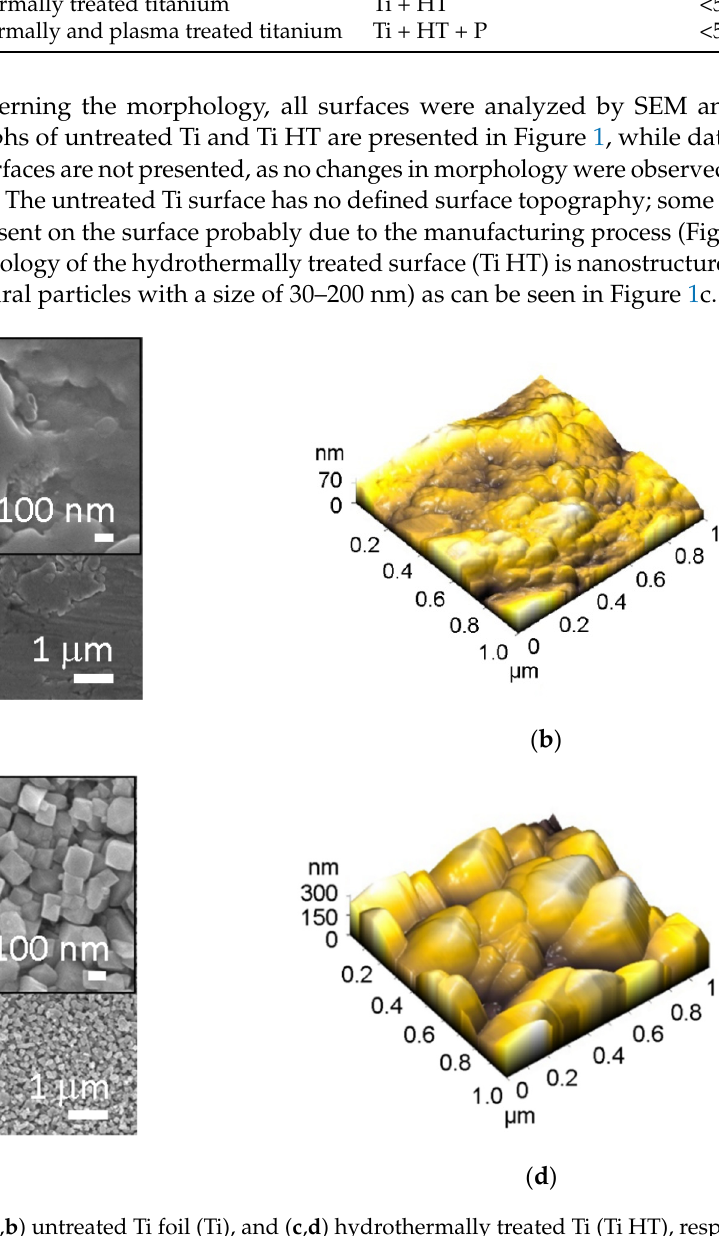
plasma treatment were detected on these surfaces. The 3D image of surface topography (Figure 1b) reveals that plain Ti foil has no defined topography; the estimated surface roughness (Ra) is about 11.7 nm for the 1 × 1 µm 2 scan area. On the other hand, much higher roughness (49 nm) was measured for the hydrothermally treated surface (Ti HT) for the same scan area. In the case of hydrothermal treatment, the evaluated height of the octahedral particles is between 180 and 300 nm. Thus, the main difference between Ti and Ti HT surface is that the TiHT exhibits homogenous structured nanotopography, which may significantly influence biological response. As determined from X-ray photoelectron (XPS) analysis (Table 2), the untreated Ti substrate consists of 48.5 at. % of oxygen, 19.5 at. % of titanium and 32.0 at. % of carbon. Oxygen concentration on the surface of Ti +P and Ti HT + P increased in comparison to pristine Ti and Ti HT; plasma-treated surfaces contained 68.5 at. % and 61.1 at. % of oxy- gen, respectively. This further indicates a higher concentration of titanium oxide on these surfaces. The carbon concentration on the sample’s surfaces decreases in the following order Ti >Ti HT> Ti HT + P > Ti + P, which confirms that plasma significantly reduces carbon contamination. The pristine Ti foil has the highest carbon contamination (32.0 at. %), followed by the hydrothermally treated surface (about 31 at %), while the lowest car- bon concentration was detected on plasma-treated surfaces (~16 at. %). Plasma treatment significantly reduced carbon on the surface, while no significant difference in the concen- tration of Ti was detected between the Ti HT and Ti HT + P surfaces (20.0 at. % and 22.3 at. %, respectively). By comparing the C/O and Ti/O ratios, it can be observed that the C/O ratio is the lowest for Ti HT + P, while the highest Ti/O ratio was observed for Ti HT (Table 2). Table 2. Chemical composition of the surface of materials examined by XPS. (Atomic %)